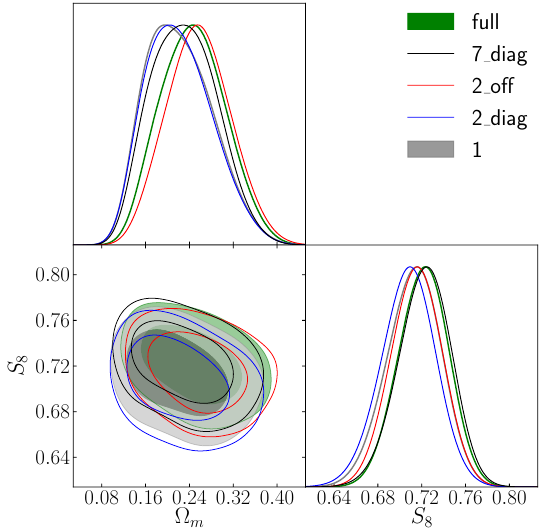
Figure 13. The same as in Figure 12, but the KL-transform is assumed to be scale-independent (see Eq. 18). the 2D Ω m - S 8 plane. It is possible to notice a